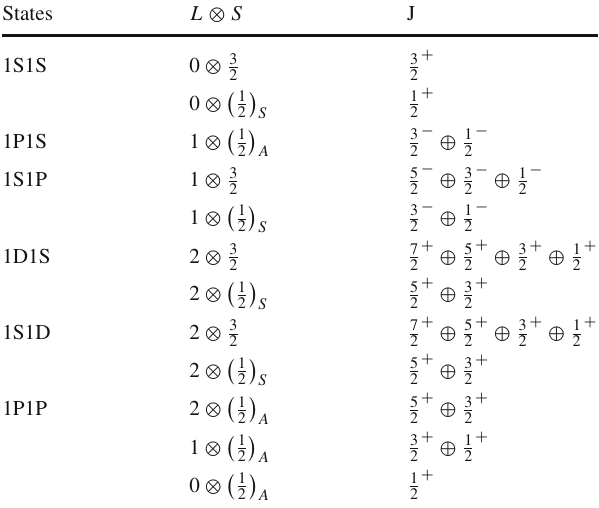
Table 1 Summary of oscillator basis states for systems ccb and bbc